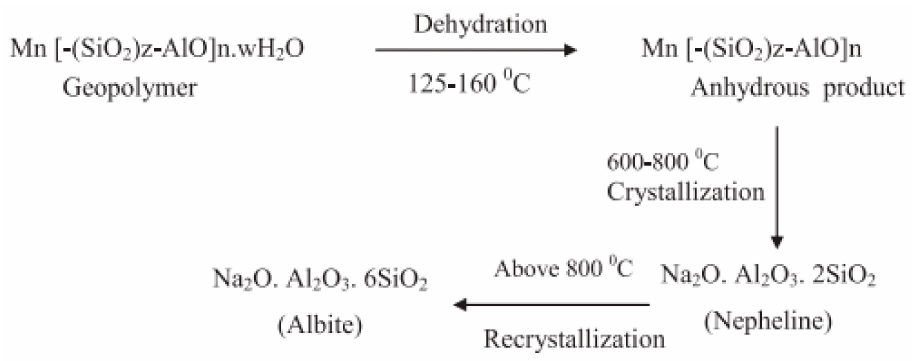
Figure 9. Influence of POFA on the concrete resistance to sulfate [40]. Reprinted with permission from Elsevier